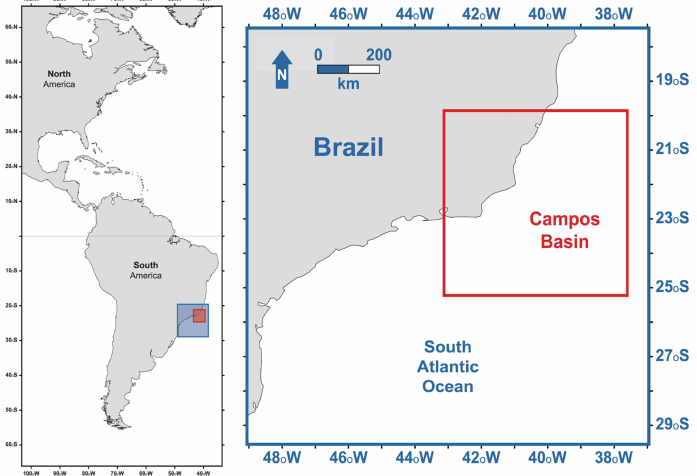
Figure 3. Region of interest: Campos Basin, Brazil. See Section 2.3. Courtesy of Adriano Vasconcelos